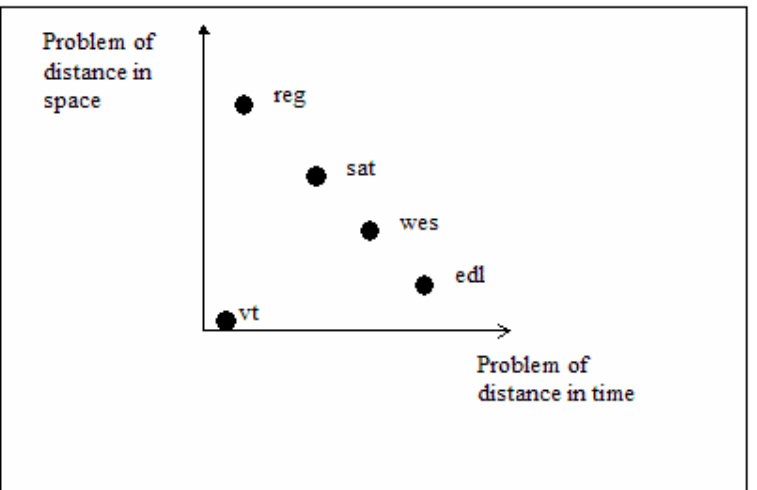
Figure 1 . The Impact of Distance in Space and Time in Various Tutorial Events